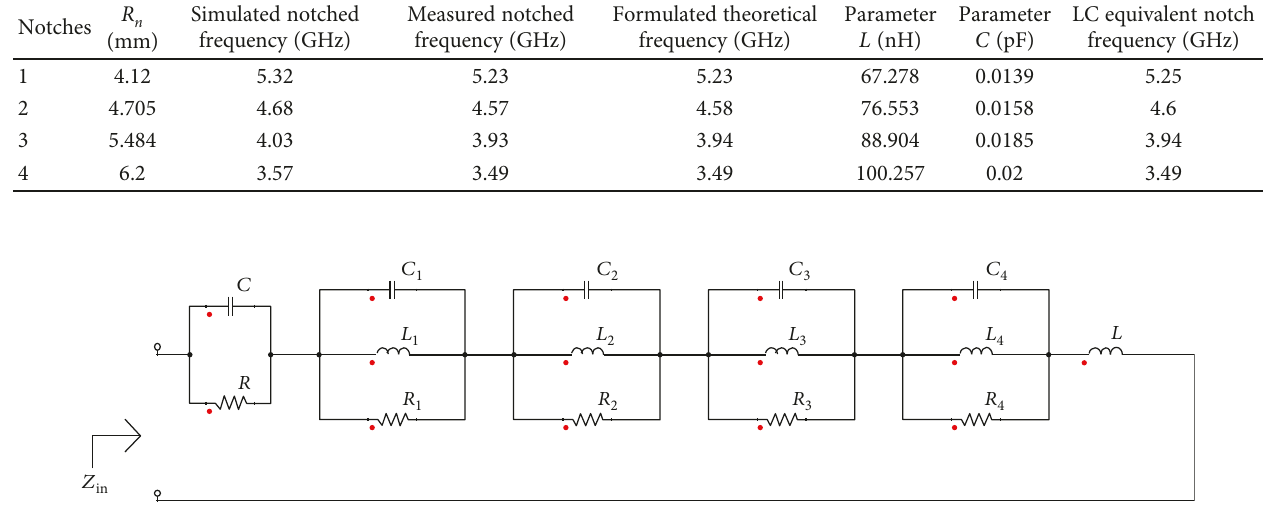
Figure 3: Equivalent lumped element circuit model of a slot etched antenna.